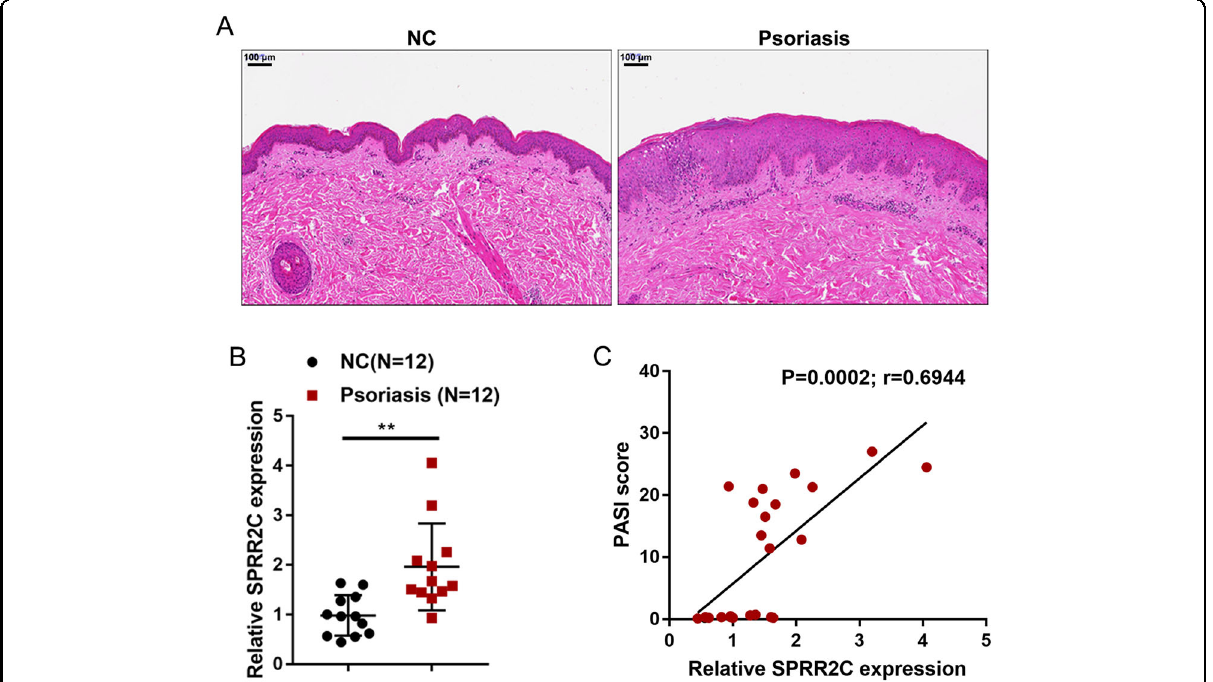
Fig. 1 Expression of long noncoding RNA (lncRNA) SPRR2C (small proline-rich protein 2C) in psoriatic tissue samples. A The histopathological features of the psoriatic lesion and nonlesion tissues examined by hematoxylin and eosin (H&E) staining. B The expression of SPRR2C was determined in 12 psoriatic lesions and 12 nonlesion tissues by real-time PCR. C The correlation of SPRR2C expression and Psoriasis Area and Severity Index (PASI) scores in clinical cases was determined using Pearson ’ s correlation